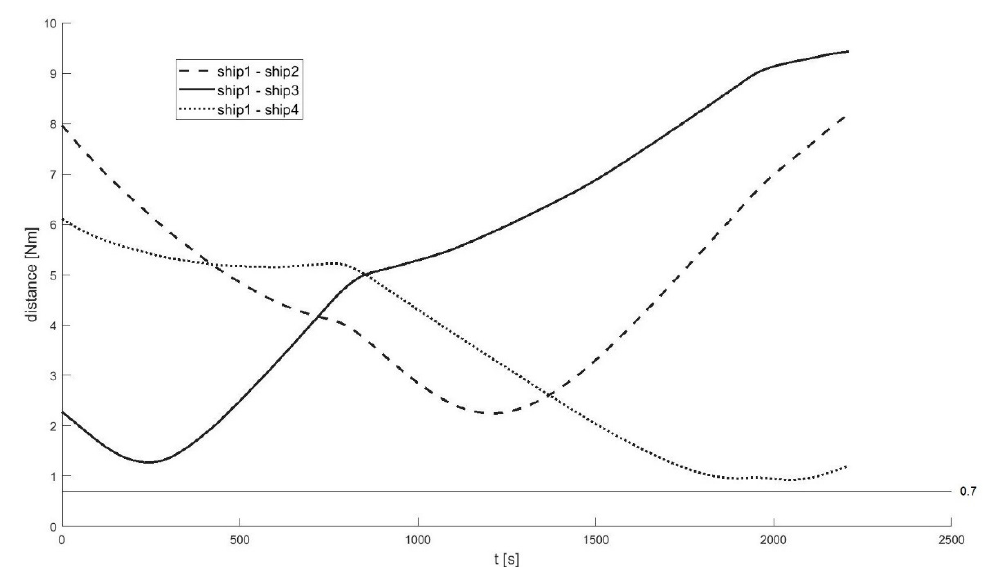
Figure 13. Execution of Scenario 2 with the anti-collision manoeuvre developed by ship 1 — Distances between the ships.